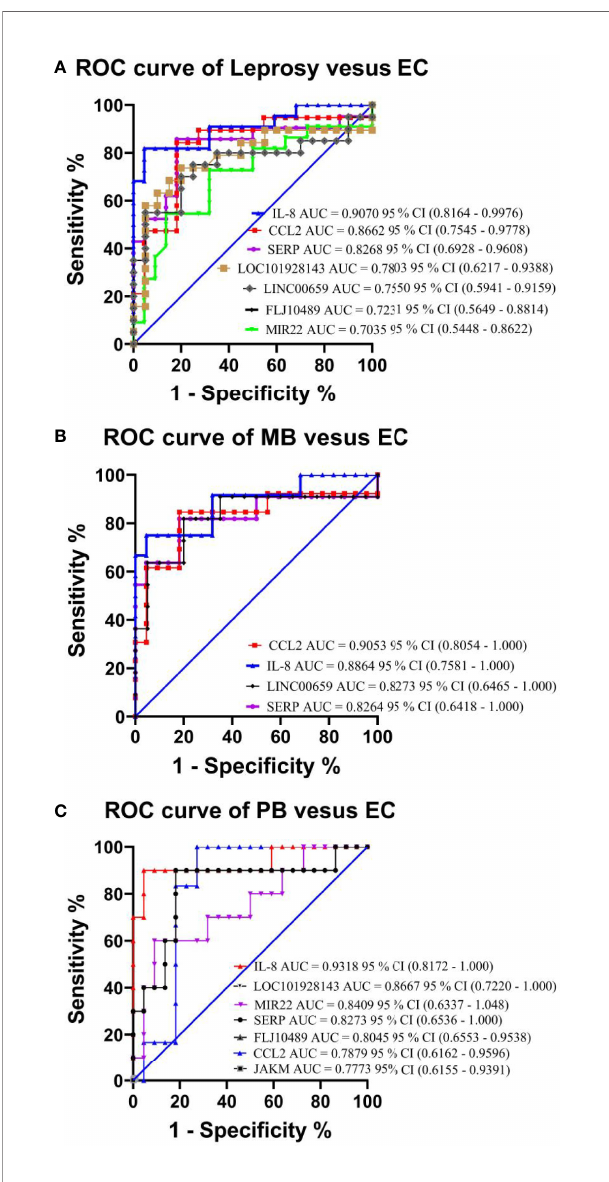
FIGURE 7 | Performance test of each selected gene in the PBMCs of leprosy patients and non-leprosy controls in the validation cohort. Panels showing receiver-operating characteristic (ROC) area under the curve (AUC) for the sensitivity and speci fi city of the selected differentially expressed genes in RT- qPCR analysis of PBMC samples in (A) leprosy patients versus ECs, (B) MB leprosy patients versus ECs, and (C) PB leprosy patients versus ECs. AUC values (with 95% con fi dence interval) obtained by running ROC analysis are also provided. The key presents the AUC values of the selected genes. CI, con fi dence interval; MB, multibacillary; PB, paucibacillary; EC, endemic